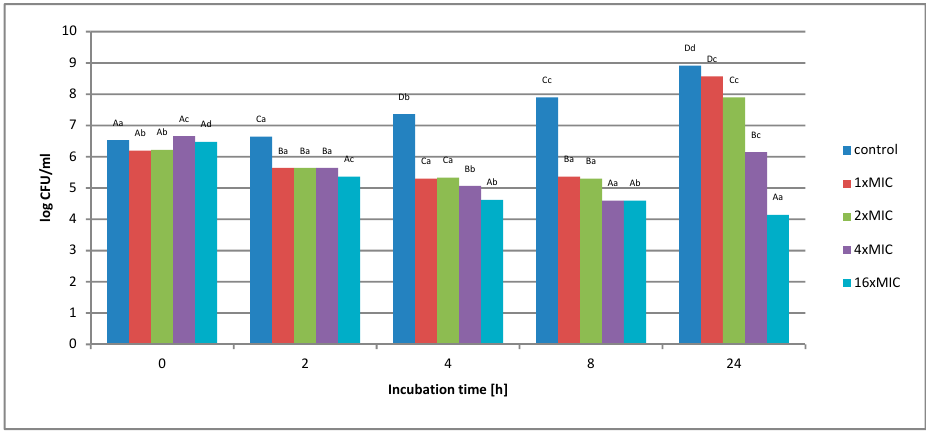
Figure 6. The effect of the aqueous extract at the concentration of 1 × MIC, 2 × MIC, 4 × MIC, and 16 × MIC on the survival of Salmonella Enteritidis in a matrix containing 6% meat extract during 24 h of incubation. A, B, C, D—the effect of matrix type on the change in the number of bacteria at the same time of storage; a, b, c, d—the effect of incubation time on changing the number of bacteria.